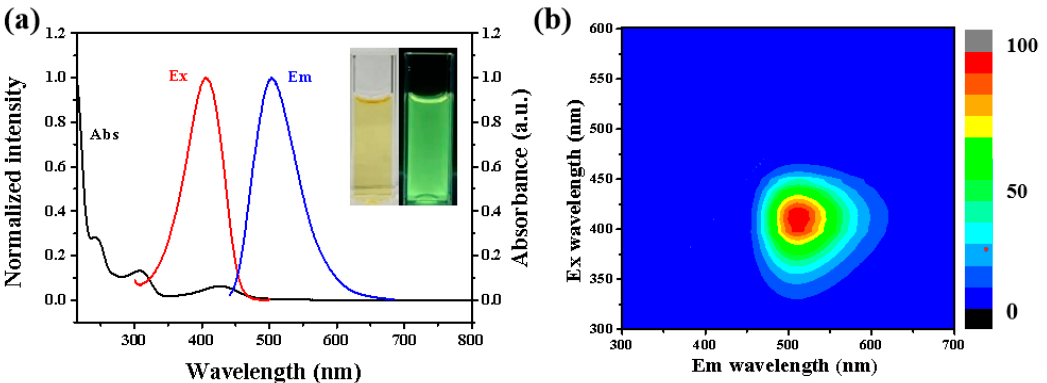
Figure 3. ( a ) Absorption (black), excitation (red), and emission (blue) spectra of the FNCDs. Inset: images of the N-CDs solution under visible light ( left ) and 365 nm UV light ( right ). ( b ) 3D fluores- cence spectrum of the FNCDs (the colors from blue to red represent the fluorescence intensity from weak to strong).